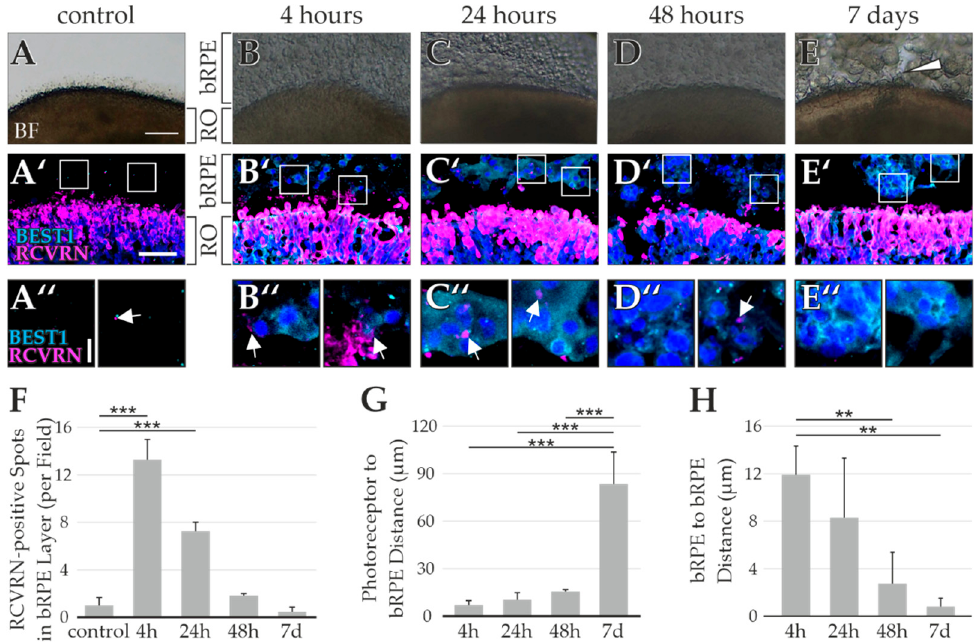
Figure 5. Cocultures of retinal organoids (RO) with byproduct RPE (bRPE) in Matrigel suspension indicate a transient functional interaction. Brightfield (BF) images are shown of ( A ) a control RO that was not suspended in the bRPE–Matrigel solution, and of cocultures after ( B ) 4 h, ( C ) 24 h, ( D ) 48 h, and ( E ) 7 days. bRPE cells were initially close to the RO, but after 1 week cavities were observed between the RO and bRPE ( E , arrowhead). ( A’ ) In the control ROs, no BEST1-positive bRPE were seen outside the RCVRN-positive RO outer nuclear layer. After co-culturing for ( B’ ) 4 h, ( C’ ) 24 h, and ( D’ ) 48 h, BEST1-positive bRPE were located near RCVRN-positive photoreceptors. ( E’ ) After 7 days there were only few bRPE aggregates close to the RO photoreceptors. ( A” ) In controls, prominent RCVRN staining was not observed outside the RO. Rarely, some discrete RCVRN-positive signals were seen (white arrow), which were judged likely unspecific. Co-cultures of ( B” ) 4 h and ( C” ) 24 h showed RCVRN uptake by the bRPE, indicting a functional interaction (white arrows). ( D” ) After 48 h, the RCVRN uptake had noticeably decreased. ( E” ) At day 7, no RCVRN uptake by the bRPE was noticed. ( F ) The co-cultures analyzed after 4 or 24 h had significantly more RCVRN-positive staining outside the RO than the control ROs, indicating that the bRPE had taken up RCVRN signals from the RO. ( G ) The bRPE were initially close to the RO photoreceptors, but migrated away from the RO after 7 days. ( H ) In contrast, the distance between individual bRPE cells steadily decreased over time, as the bRPE formed aggregates within the Matrigel. RO age: > 180 days, bRPE age: 119 days. Scale bar ( A – E ) 100 µ m, ( A’ – E’ ) 50 µ m, ( A” – E” ) 10 µ m. White squares in E’–D’ indicate the location of the enlarged images shown in ( A” – E” ). ** p < 0.01, *** p < 0.001 (Bonferroni-corrected). RCVRN uptake by bRPE was observed after 4 and 24 h (Figure 5B”,C”, respectively, white arrows), likely indicating a functional interaction between the photoreceptors and bRPE cells. After 48 h the RCVRN uptake by bRPE had markedly decreased (Figure